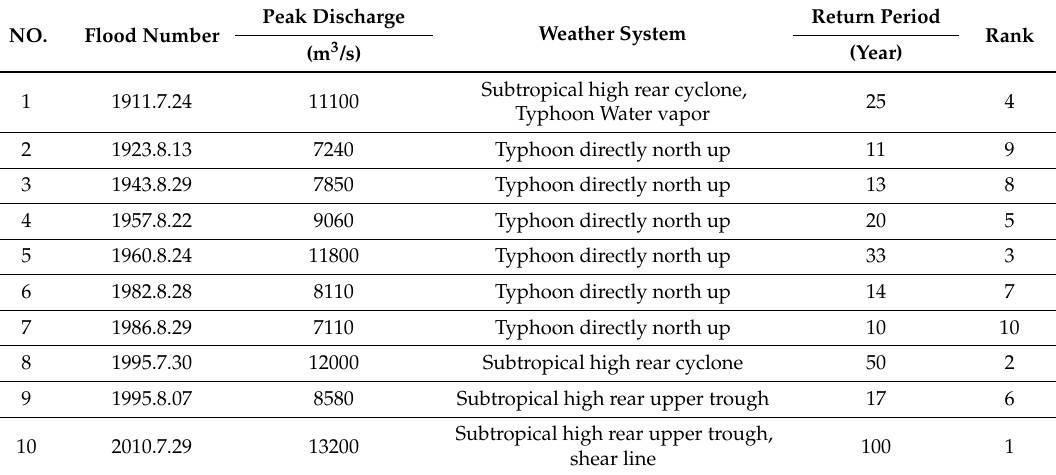
Table 3. Historical floods in the White Mountain